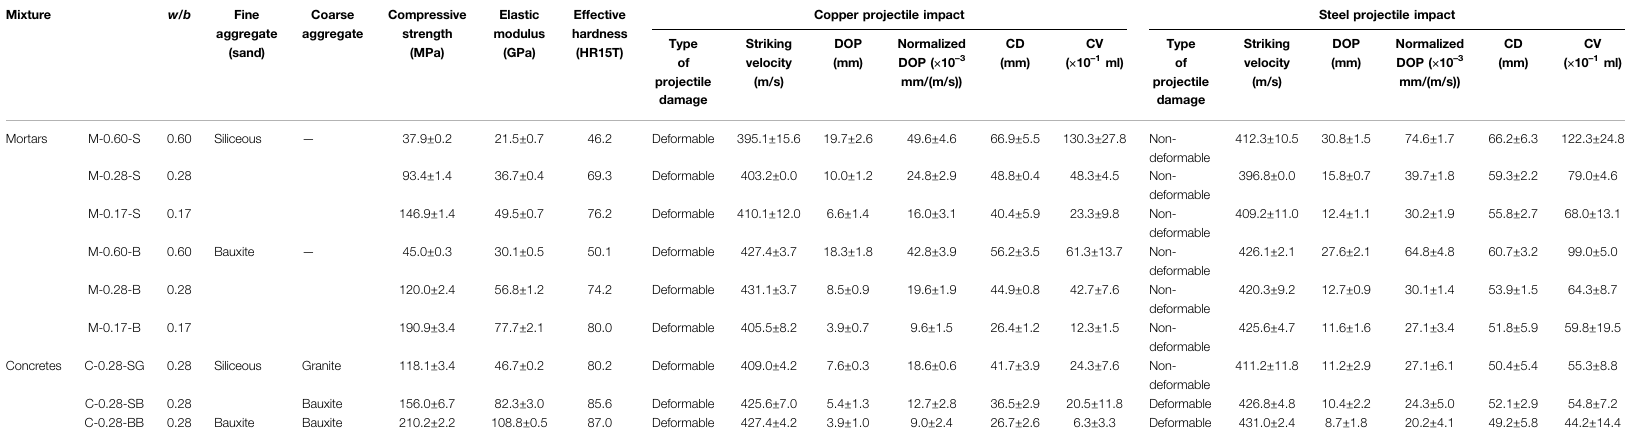
TABLE 4 | Summary of the DOP, CD, and CV in cement composites subjected to copper and steel projectile impact. Mixture